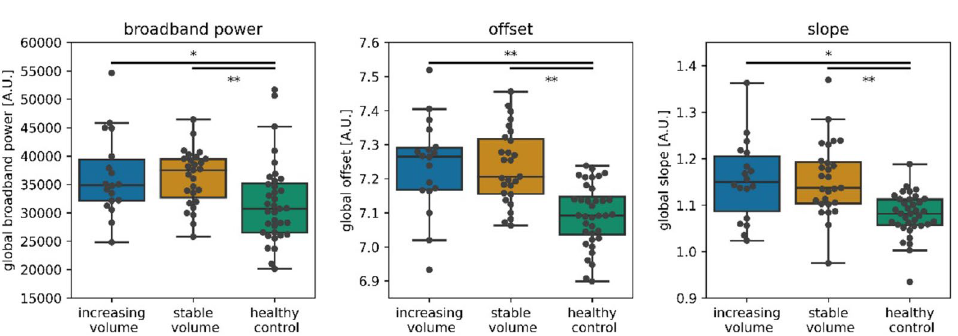
Figure 3. Global brain activity across groups. Global brain activity was not different between patients with stable versus increasing tumor volumes after correcting for the three comparisons drawn. Both glioma groups showed higher global brain activity compared to healthy controls. Individual patients are represented by black dots. * P = 0.001, ** P < 0.001, significant after correction for the six comparisons drawn (three activity values, two group comparisons per activity value). A.U. = arbitrary